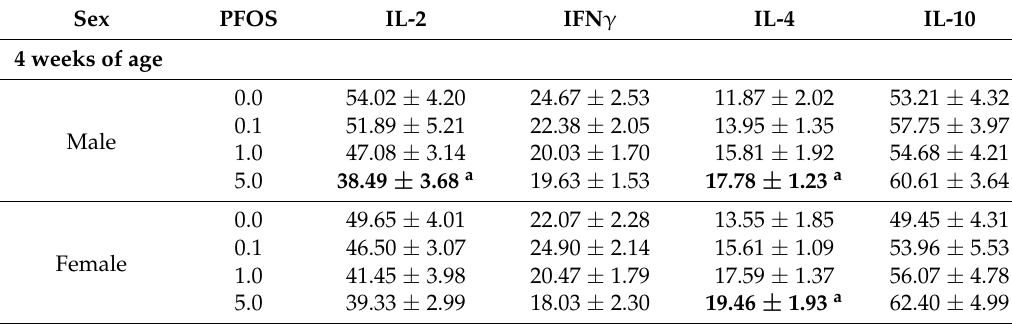
Table 4. Spontaneously-formed T H 1- and T H 2-type cytokines in culture supernatants of splenocytes harvested from C57BL6 pups exposed in utero to PFOS during GD